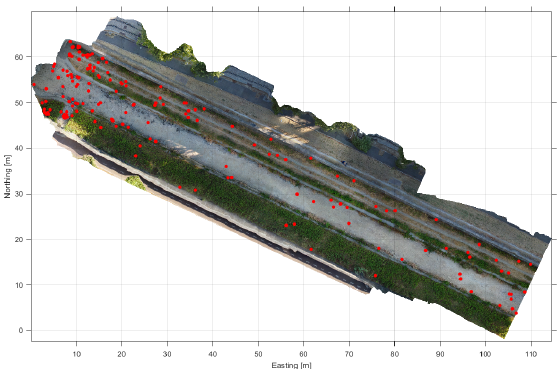
Figure 1. Litter objects (red marks) on the study area.